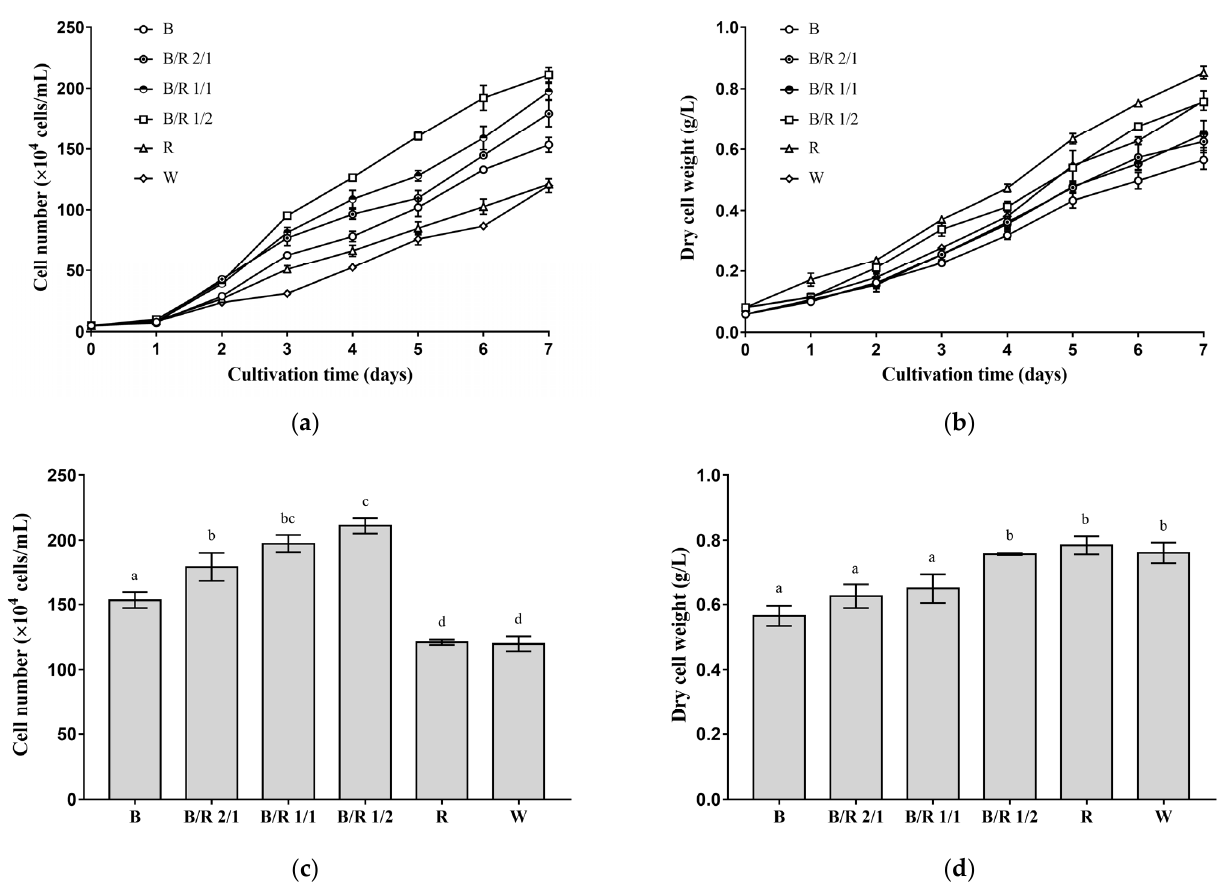
Figure 1. Effects of light spectra on the growth of H. pluvialis green cells. ( a ) Growth curves based on cell number; ( b ) growth curves based on dry cell weight; ( c ) cell number obtained at the end of cultivation; ( d ) dry cell weight obtained at the end of cultivation. In ( c , d ), the same lowercase letter means insignificant difference, while different lowercase letters mean significant difference. In ( a – d ), B—blue light; B/R—blue light/red light; R—red light; W—white light. Results were presented as mean ± SD of the measurements of three biological replicates.